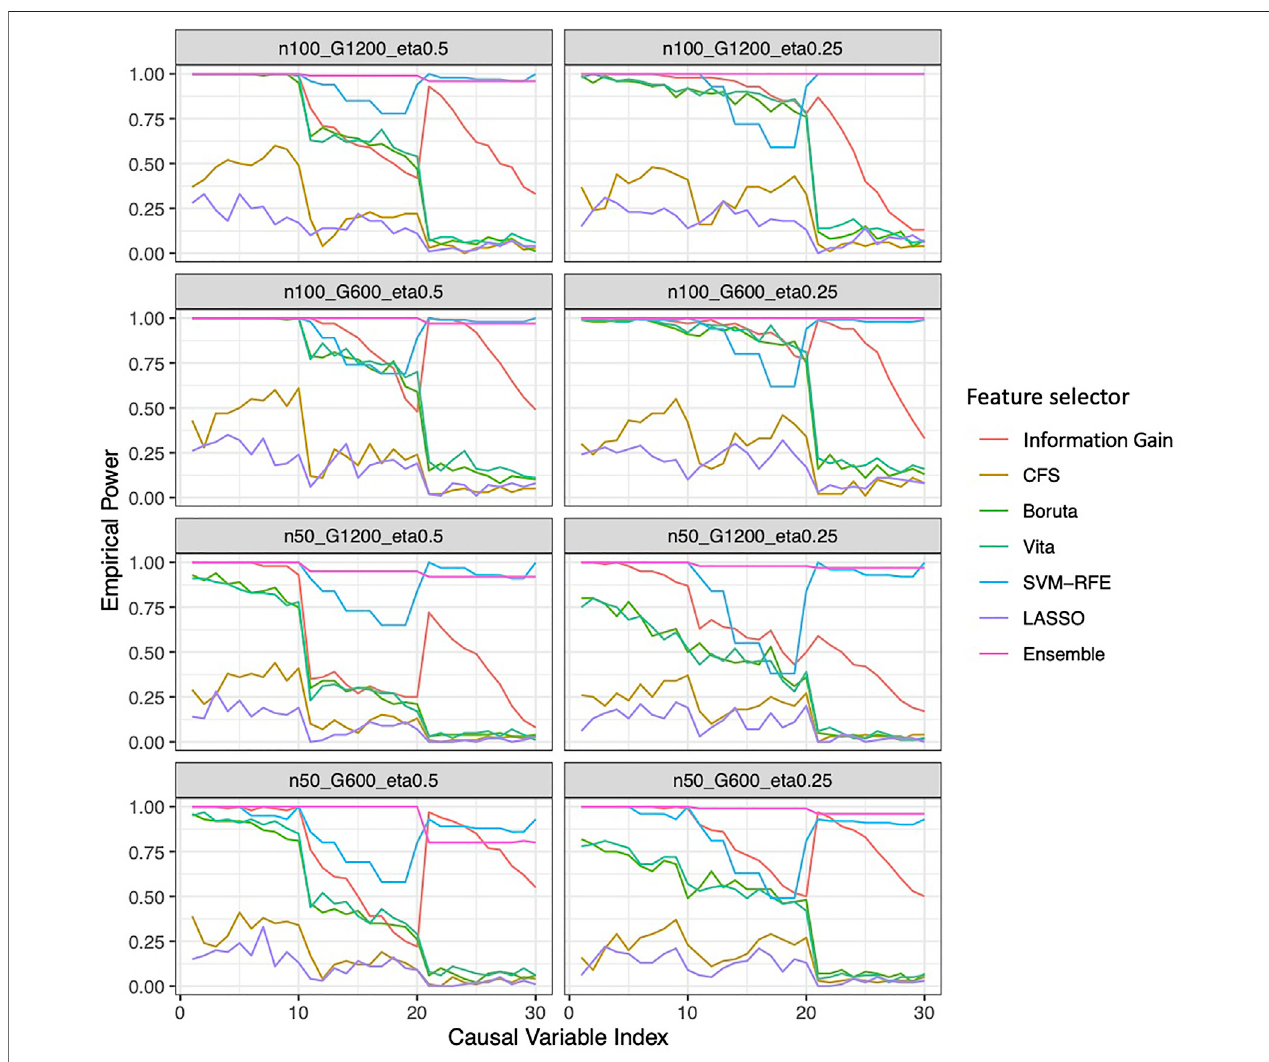
FIGURE 4 | Empirical power of the feature selection approaches based on simulation. Each panel represents different simulation scenario listed in Table 2 . For example,n50_G600_eta0.5standsforsamplesizeis50with600candidategenesandtheprobabilityoftheoutcomeis0.5.Ineachpanel,x-axisstandsforthenumber of causal